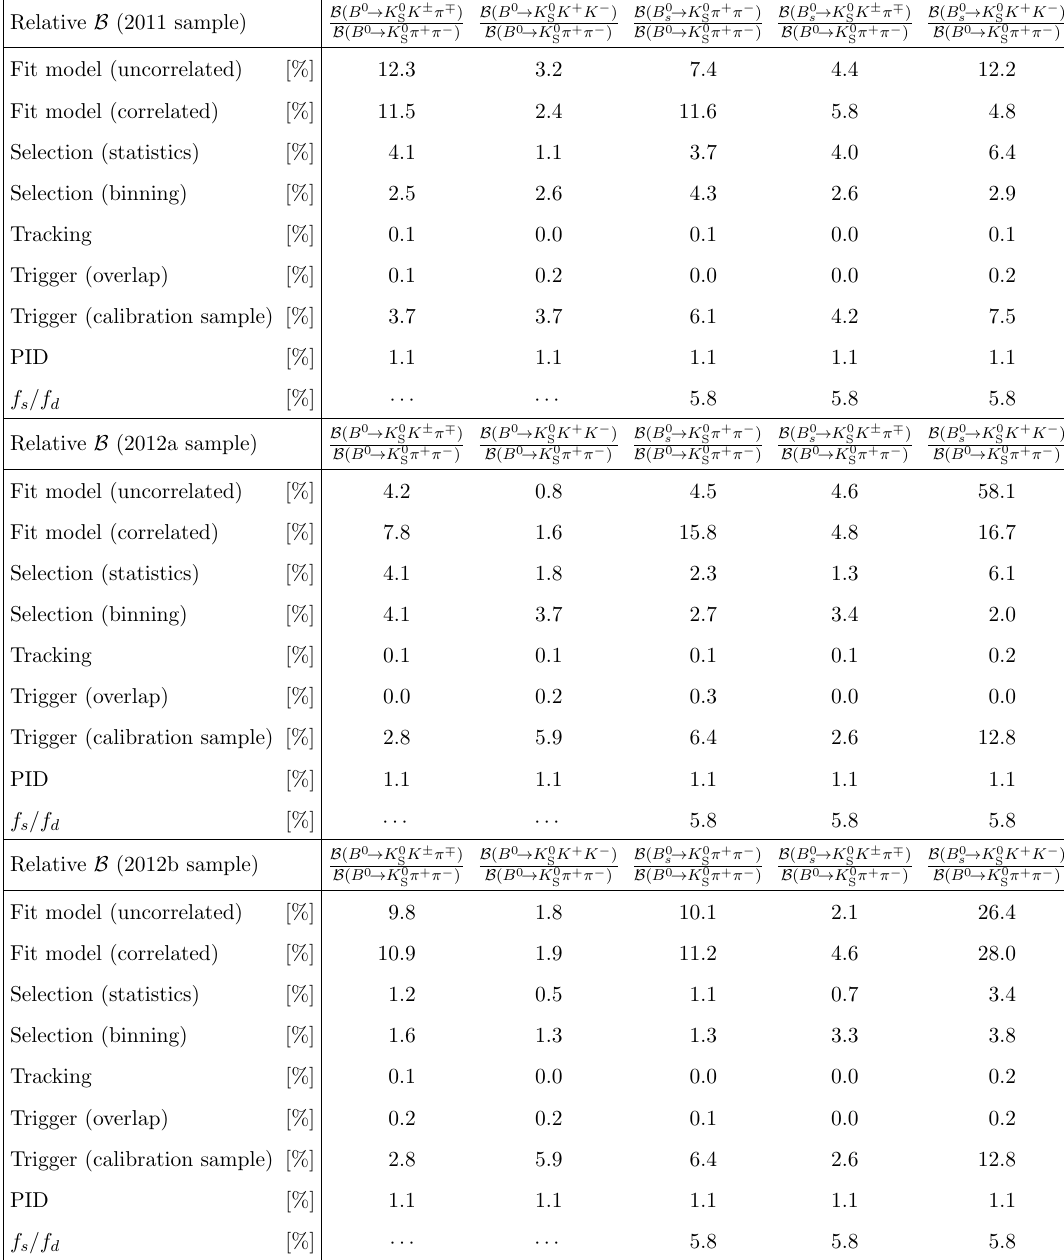
Table 6 . Systematic uncertainties on the ratios of branching fractions for downstream K 0 struction. All uncertainties are relative and are quoted as